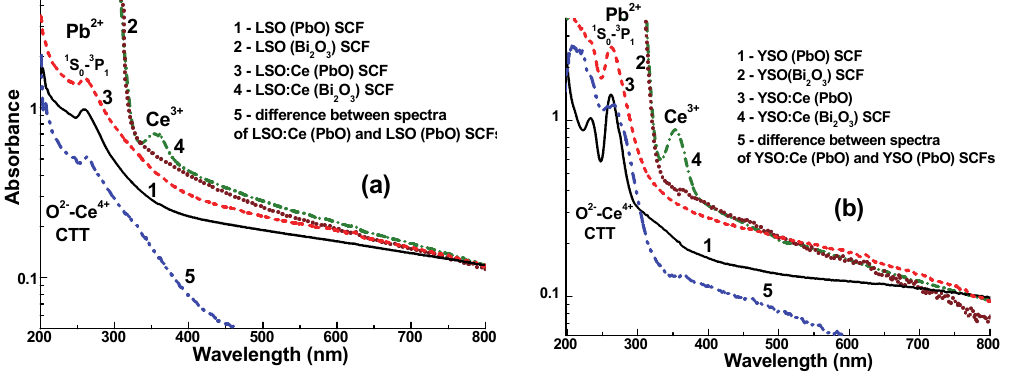
Figure 1. Absorption spectra (in the log scale) of LSO (a) and YSO (b) SCFs (curves 1 and 2) and LSO:Ce (a) and YSO:Ce (b) SCFs (curves 3 and 4), grown from PbO (curves 1 and 2) and Bi 2 O 3 (curves 3 and 4) based fluxes. The difference between the spectra of LSO:Ce (PbO) and LSO (PbO) SCFs (curve 5a) and YSO:Ce (PbO) and YSO (PbO) SCFs (curve 5b) shows the presence of O 2- → Ce 4+ charge transfer transition (CTT) bands in the absorption spectra of LSO:Ce and YSO:Ce SCFs, grown from PbO based flux. The absorption spectra of YSO:Ce and LSO:Ce SCFs grown from Bi 2 O 3 flux are characterized by very strong bands peaked below 320 nm which are related to the 1 S 0 → 3 P 1 transitions of Bi 3+ ions [18].